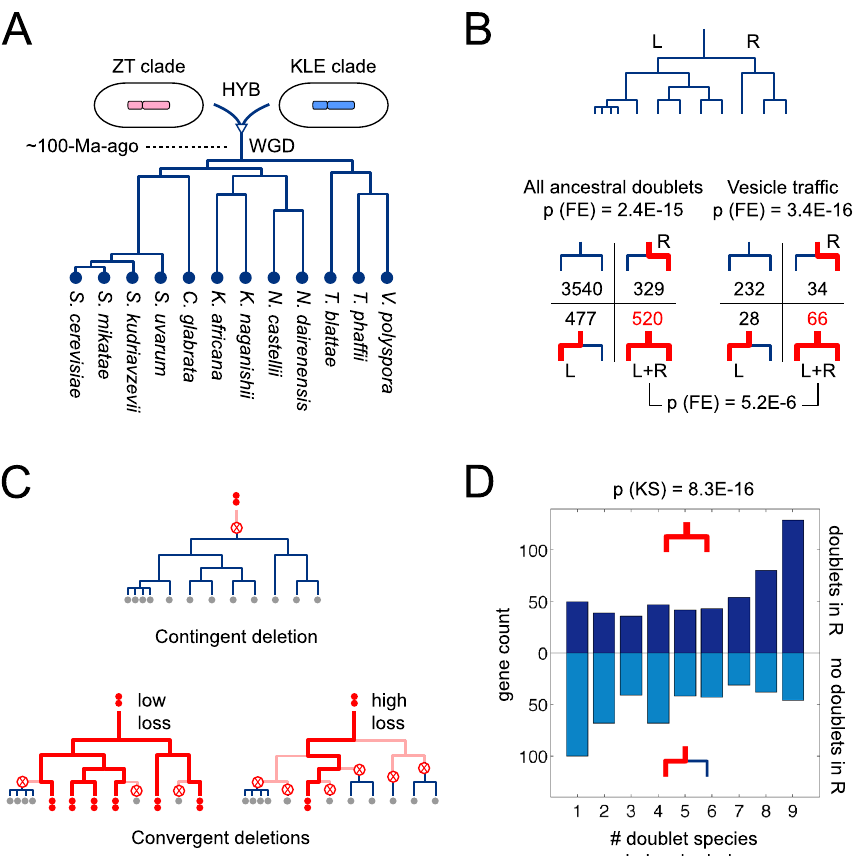
Figure 1. Convergent retention of paralog doublets after whole genome duplication. ( A ) The yeast WGD clade is descended from a hybridization between parents related to present-day members of the ZT and KLE clades, followed by a whole genome duplication event. See Fig. 4 for more details. Phylogenetic branch lengths are from Ref. 12 . ( B ) Top: Cladogram based on the phylogenetic tree from ( A ), indicating the left (L) and right (R) sub-clades. Bottom: Each paralog can be placed into one of four groups depending on whether it is present as a doublet in any member of the L or R sub-clades. We show the total number of paralogs in each of these groups, for all 4866 ancestral doublets (left) and the 360 ancestral doublets encoding vesicle traffic proteins (right). P-value calculations are described in the main text and “Methods”. ( C ) Paralog doublets (double red dots) can revert to singletons (single gray dots) by loss of one gene copy (crossed circle). Bold red lines: lineages where presence of a doublet can be inferred, since a doublet is present in a descendant. Light pink